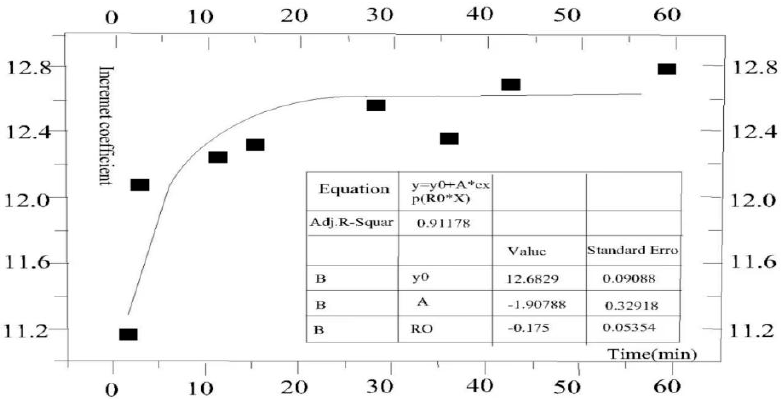
Figure 10. Relationship between the incremental coefficient k and time for different water contents in BSA in brick slag aggregate [90].